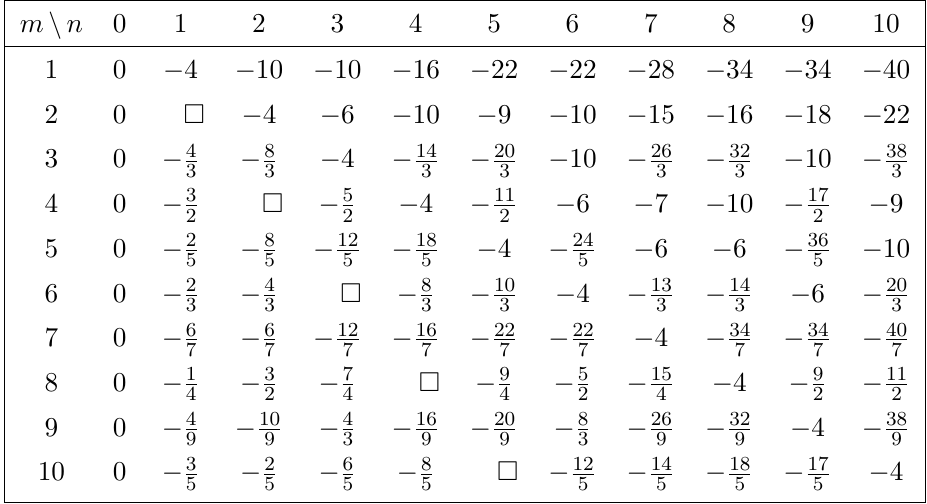
Table 3 . Table of values of (cid:17) 0 ( m; n ). Notice that m 2 (cid:17) 0 is always an integer and that (cid:17) 0 only depends on the combination n=m . The squared boxes mark the slots corresponding to pairs ( m; n ) that are proportional to the pair (2 ; 1) for which the regulator (cid:15) fails (see the last paragraph of appendix